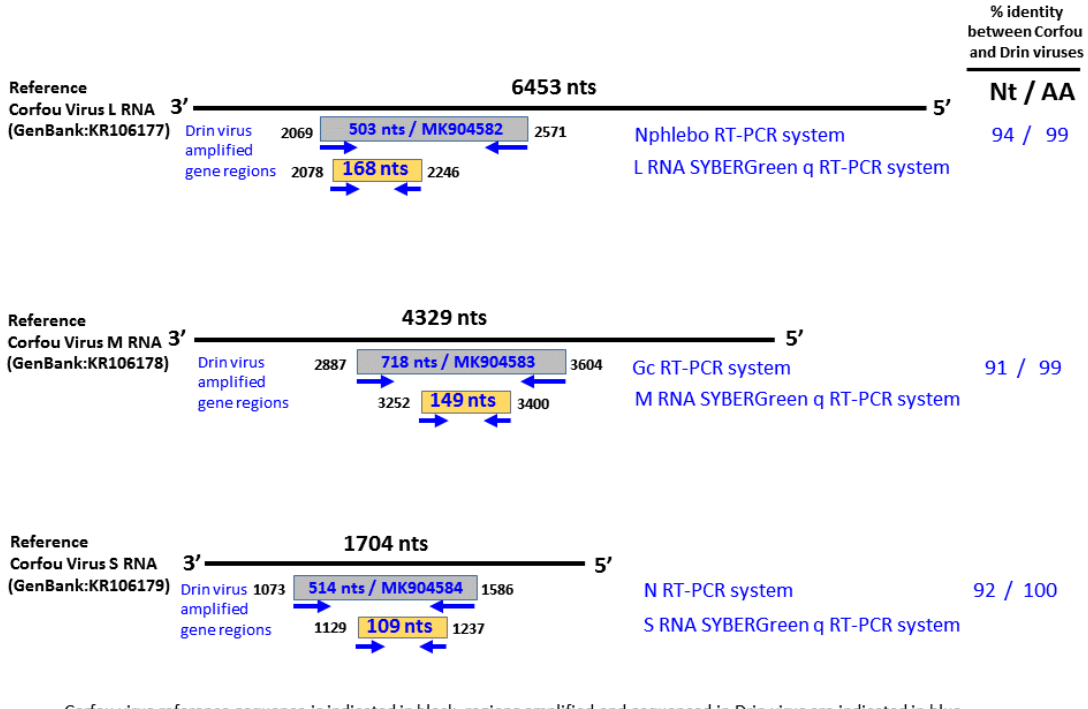
Figure 2. Schematic representation of specifically designed